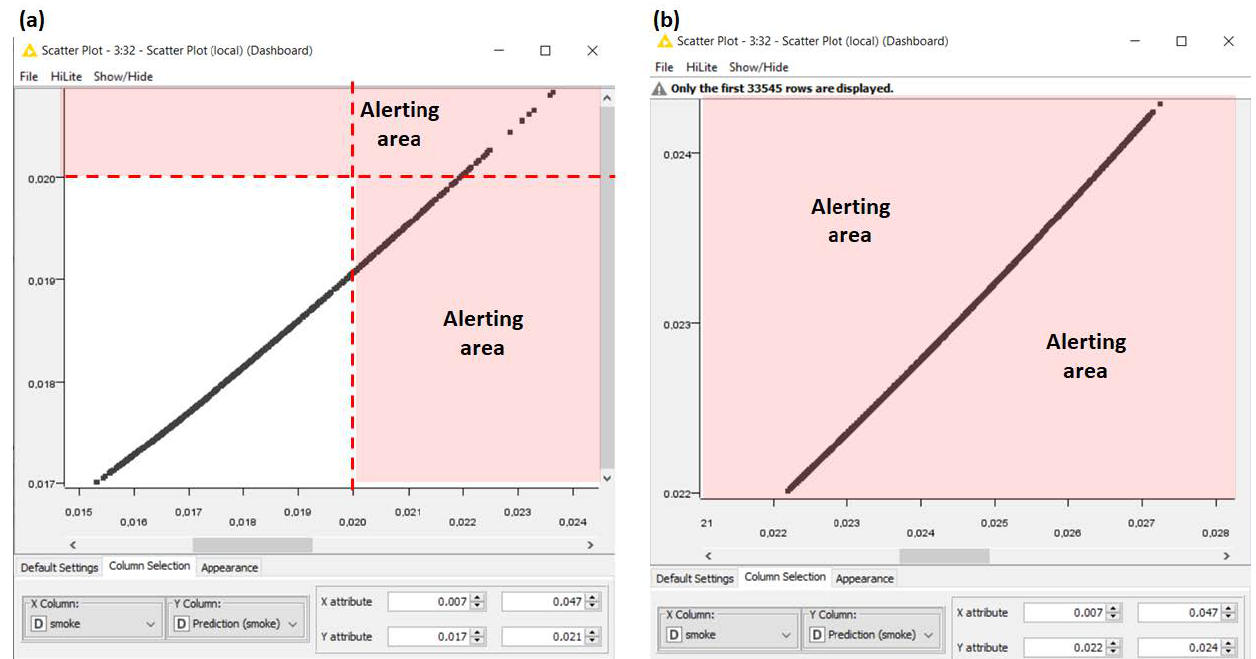
Figure 8. KNIME ANN-MLP algorithm predicting smoke variable. Plots of smoke versus predicted smoke for location 1 ( a ), for location 2 ( b ), and for location 3 ( b ). The red area represents the alerting condition.